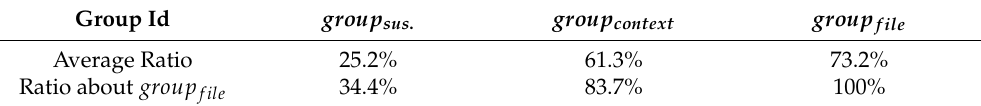
Table 3. Result of hit ratio.